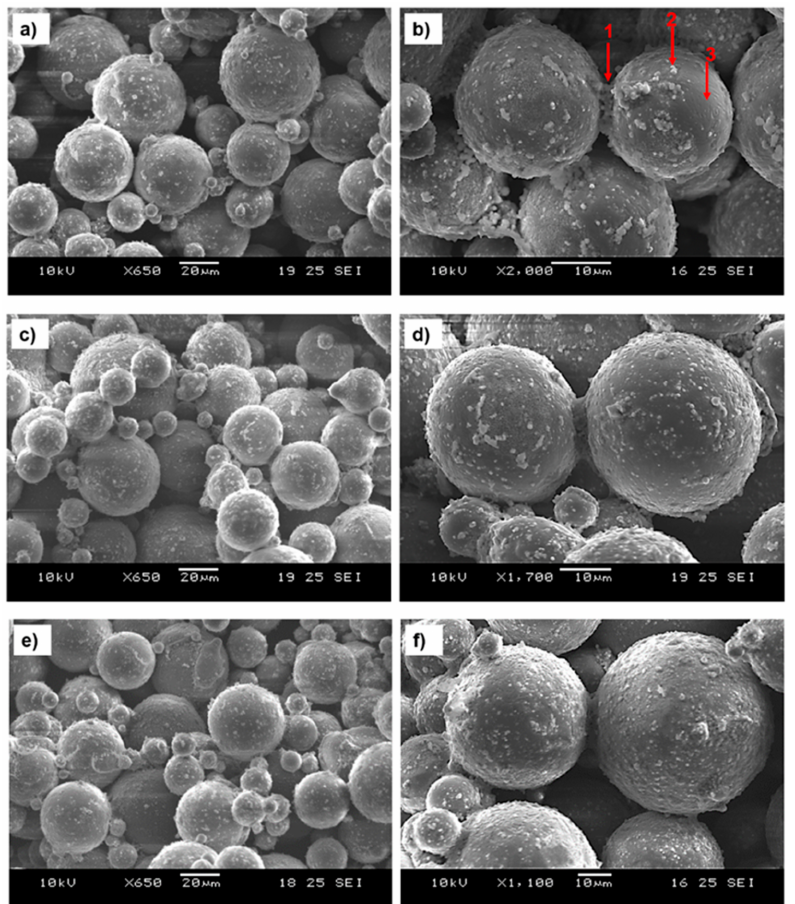
Figure 4. SEM images of the green AZ91 objects printed with various SLs showing the capillary- mediated solid interparticle bridges linking the AZ91 powder particles, ( a , b ) 70% SL, ( c , d ) 90% SL, and ( e , f ) 110%